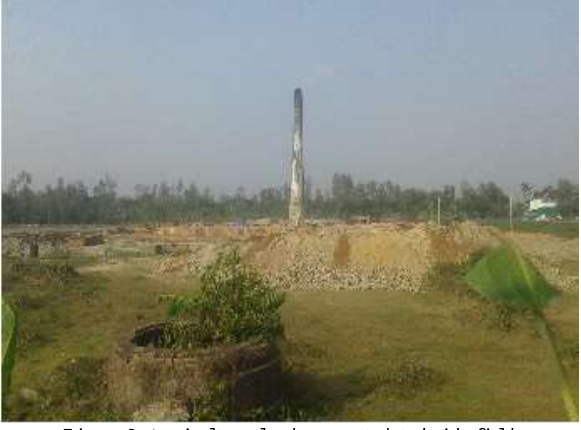
Figure 8. Agriculture land converted to